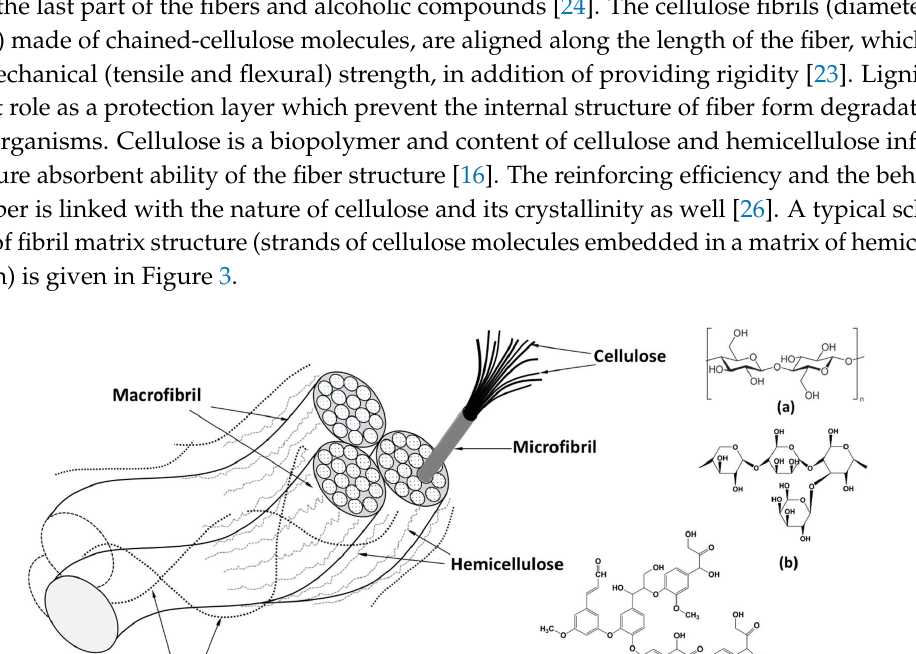
Figure 2. Schematic illustration for categorization of natural fiber incorporated in soil reinforcement.